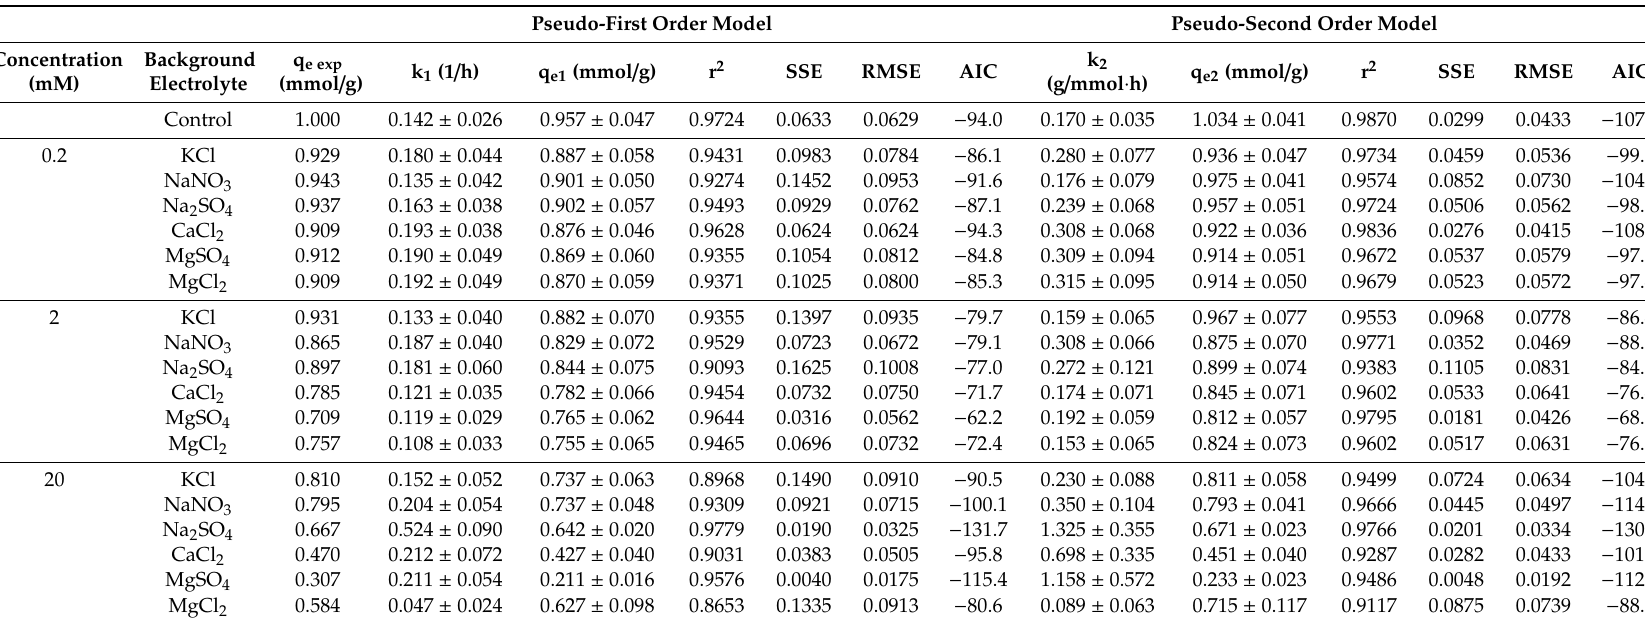
Table 4. Parameters of the pseudo-first order and pseudo-second order models for the biosorption of Ni 2 + by QCS at 0.2, 2, and 20 mM of background electrolytes. Pseudo-First Order